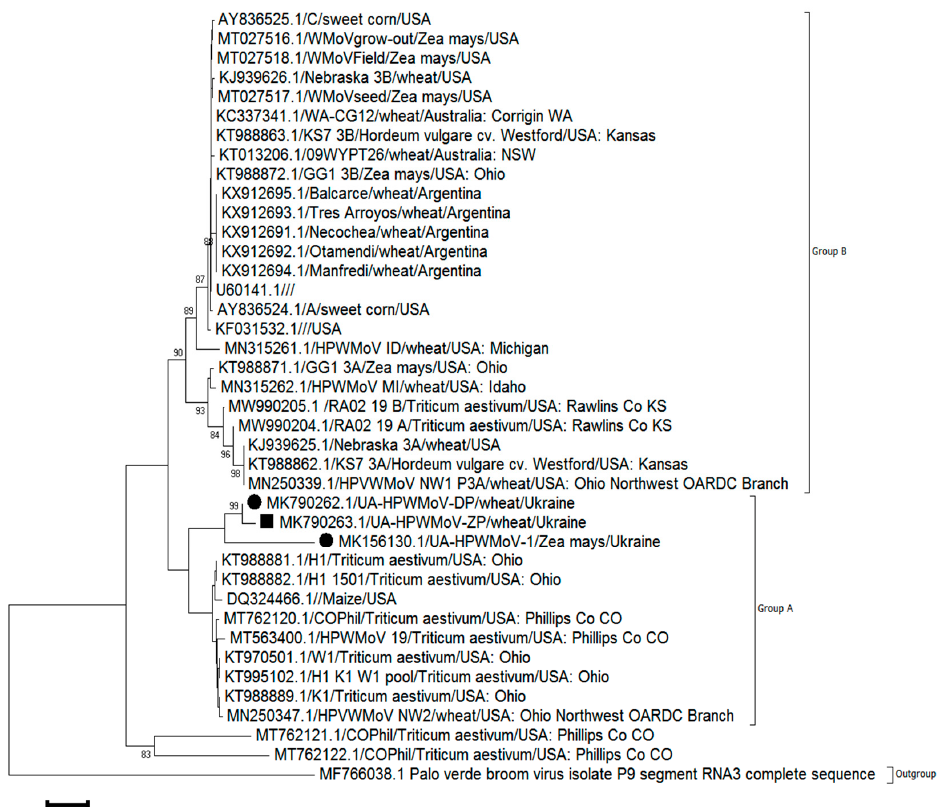
Figure 6. Neighbor-Joining (NJ) tree showing phylogenetic relationships between the isolates of High Plains wheat mosaic virus (HPWMoV). The nucleoprotein gene region was used to construct the tree. Ukrainian isolates studied in this work are shown with dots (monoinfection of HPWMoV) and squares (mixed infection with wheat streak mosaic virus (WSMV)). Bootstrap values <70 are not shown for respective branches. Palo verde broom virus sequence (MF7666038/1) was used as outgroup. Scale bar indicates 0.05 base substitutions/site.